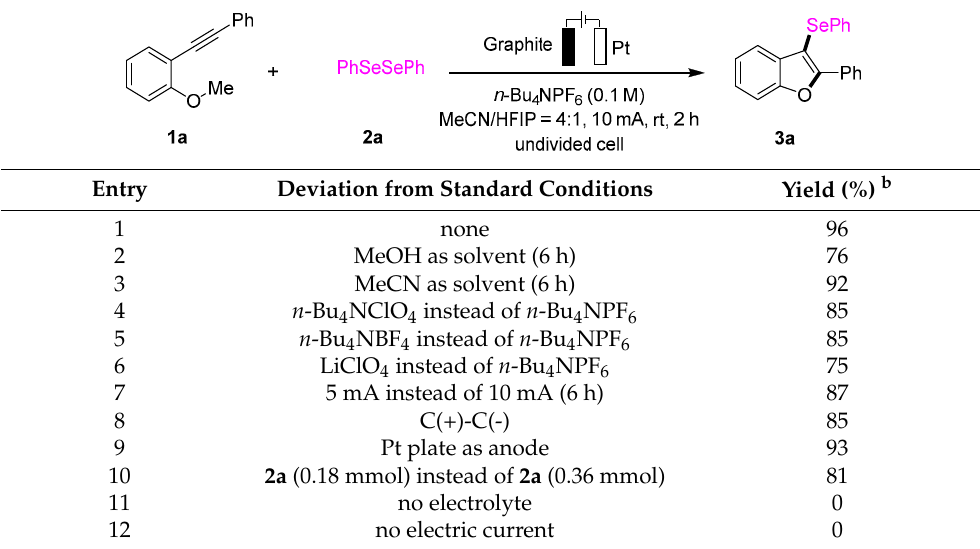
Molecules 2022 , 27 , x FOR PEER REVIEW 3 of 18 Scheme 1. Diverse synthetic strategies for selenylbenzofurans. ( a ) Transition-metal mediated selenylation/cyclization of alkynes. ( b ) Direct C − H selenylation of heteroarenes. ( c ) Direct elec- trooxidative selenylation/cyclization of alkynes.